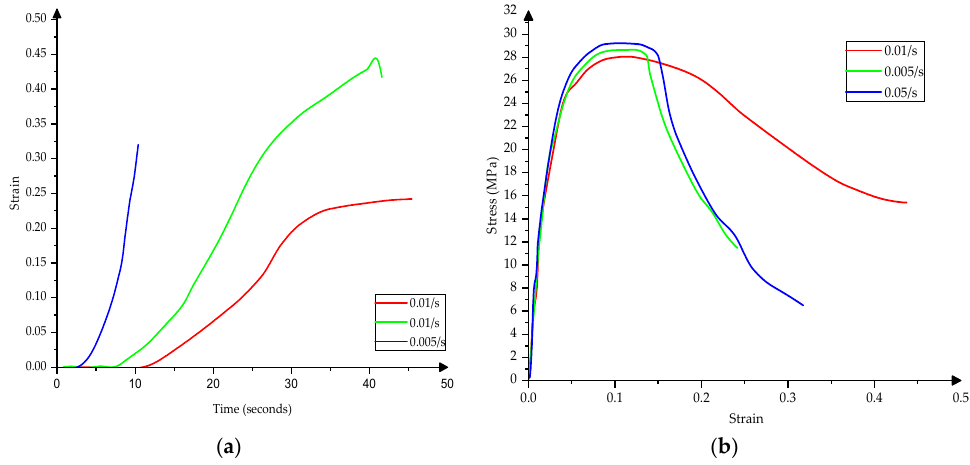
Figure 6. The constitutive model ( a ) Strain–Stress and ( b ) Stress–Strain of HDPE pipes. Figure 7 presents a generic stress–strain constitutive model specific to all three types of terrain used in the numerical model.